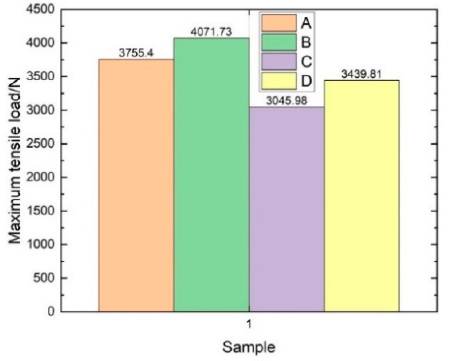
Figure 18. Maximum weft tensile load diagram.